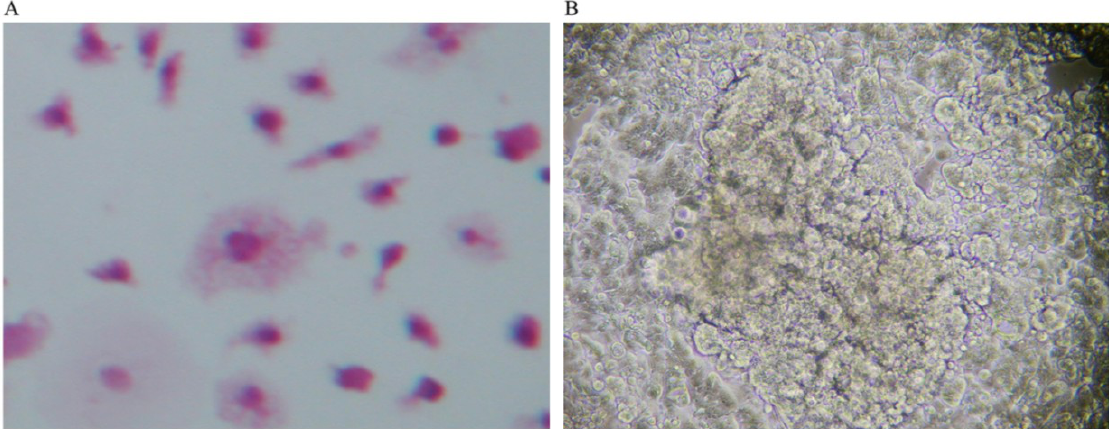
Figure 1. ( A ) Haematoxylin-eosin staining (magnification 300×); in the absence of GcMAF, small macrophages do not appear to interact with MCF-7 human breast cancer cells. The picture refers to 40 h co-culture. ( B ) Phase contrast microphotography (300×) of a cluster of cancer cells in the center. ( C ) At higher magnification (1200×) the cells appear densely packed. ( D ) Papanicolau staining (1200×); a cluster in the left lower side of the image. The nuclei are heavily stained and the perimeter of the cells is linear with no indents or signs of